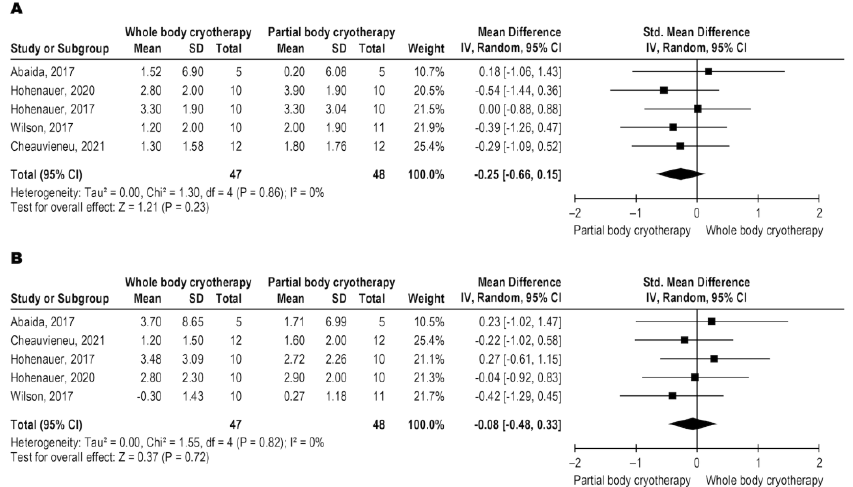
Figure 4. Metanalysis comparison between WBC and PBC for DOMS ( A ) 24 h after intervention and ( B ) 48 h after intervention [5,13,16,20,25].